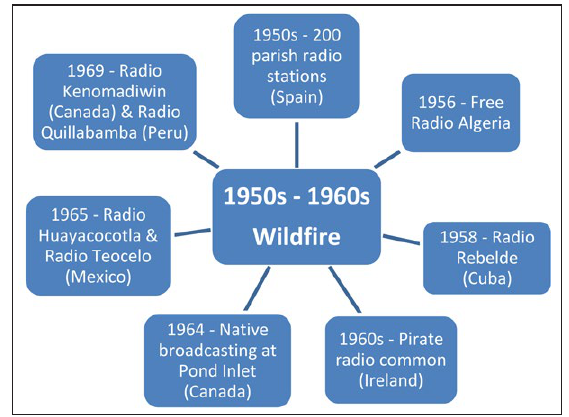
Figure 3: Wildfire period of community radio